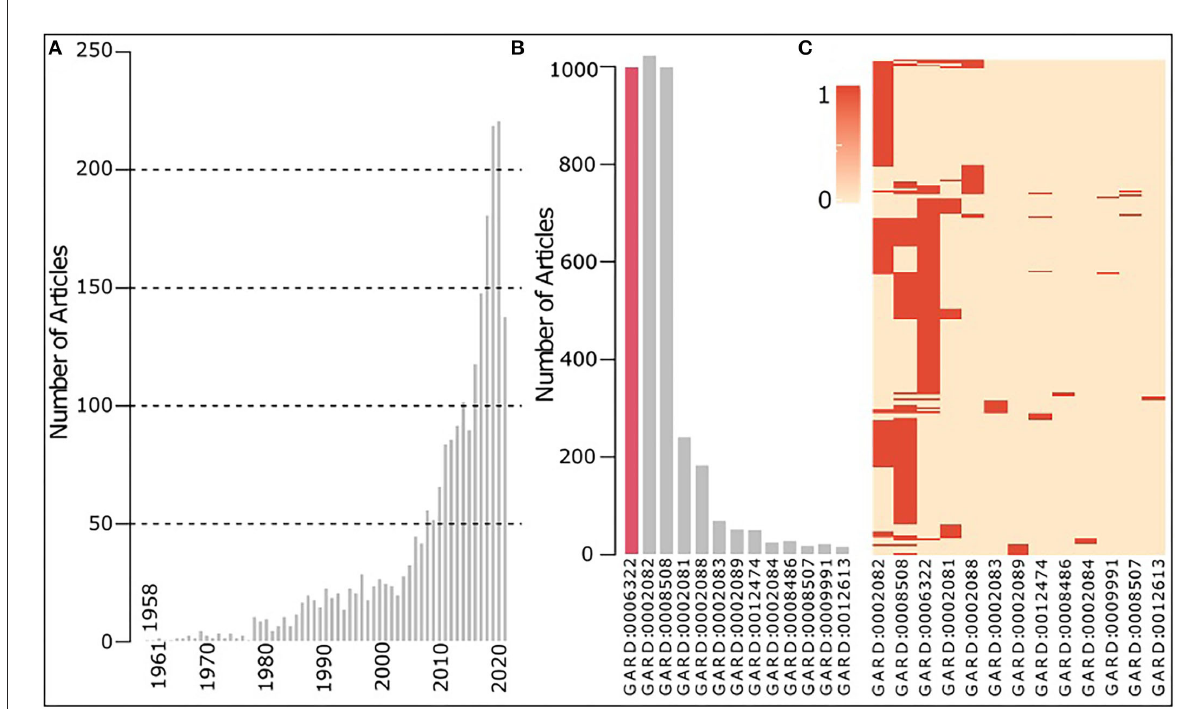
FIGURE4 Overview of EDS research collected in PubMed between 1900 and 2021. (A) Research on EDS increased over years since its first publication in 1958. (B) Number of articles on each type of EDS with the bar of the parent EDS (GARD:0006322) in red. (C) Heatmap showing multiple types of EDS (column) discussed in one article (row), in dark red indicating the disease mentioned in an